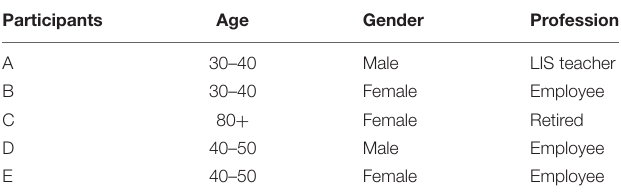
TABLE 1 | Information about the